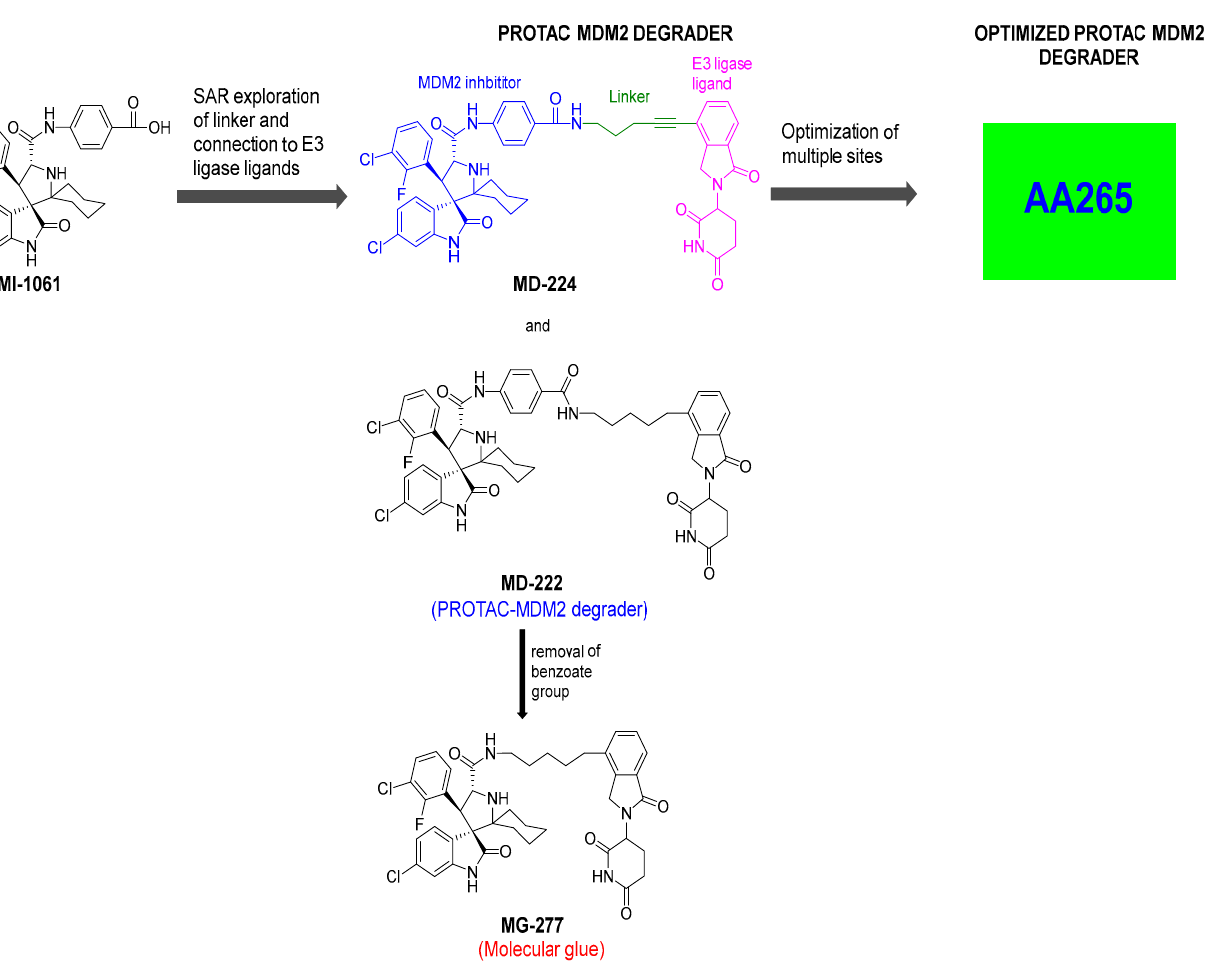
Figure 7. Chemical structure of PROTAC–MDM2 degraders.